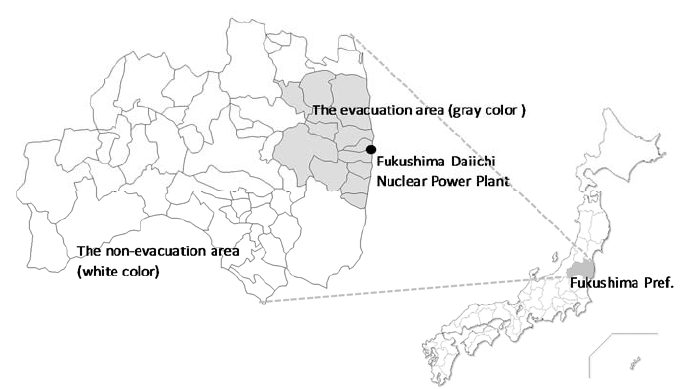
Figure 1. Location of the Fukushima Daiichi Nuclear Power Plant and the evacuation/non-evacuation areas. The gray color shows the evacuation area and the white color shows the non-evacuation area (as of December 2015).